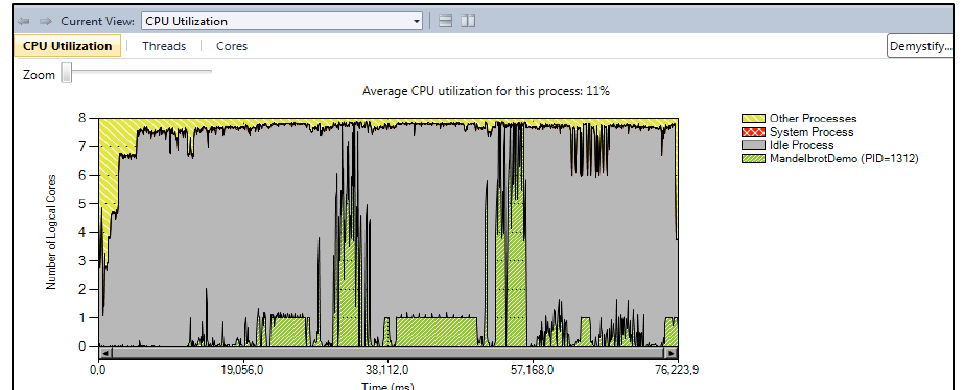
Figure 13. This is a figure. Schemes follow the same formatting.